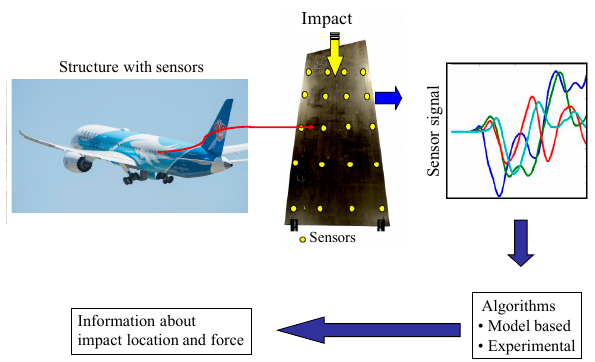
Figure 9. Principle of impact monitoring.